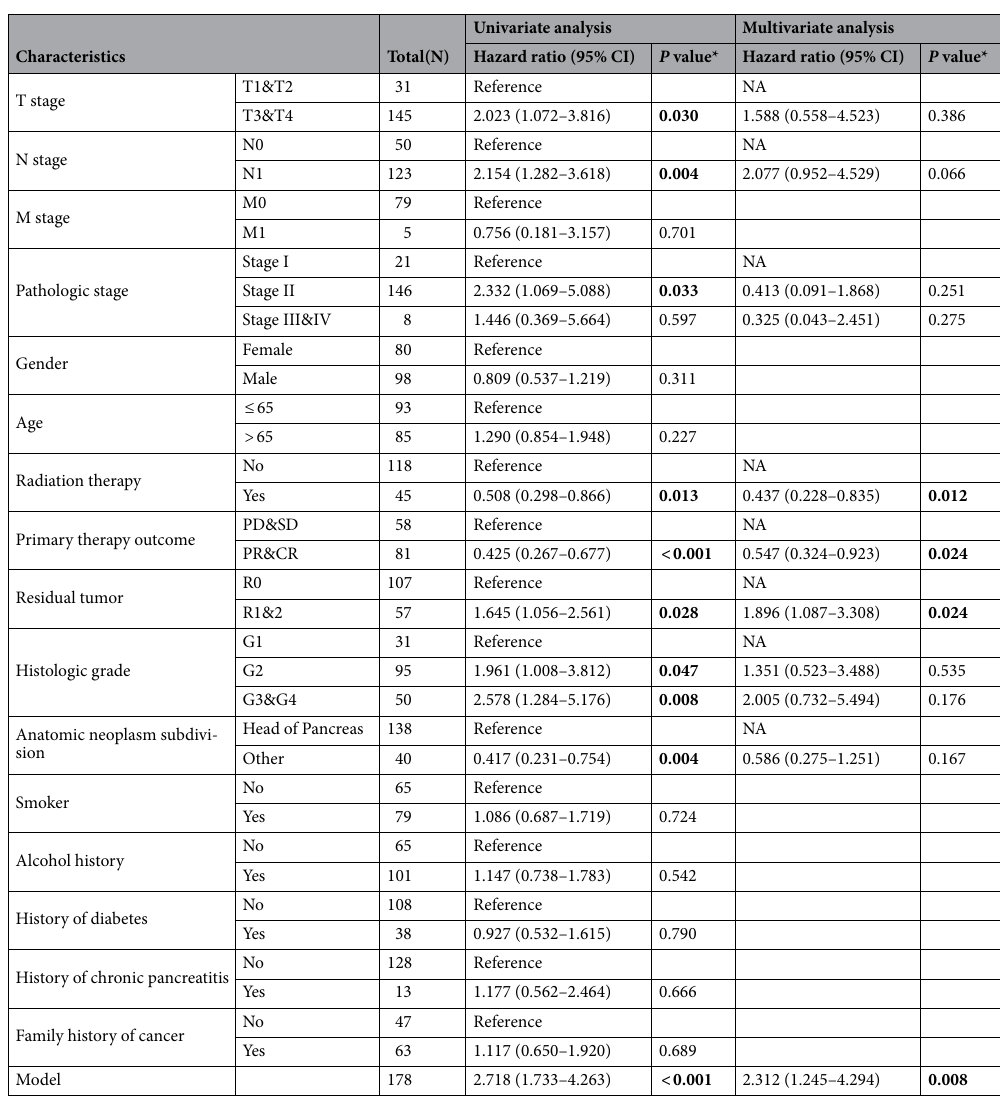
Table 2. The univariate and multivariate analysis for the OS (TCGA-PAAD). OS overall survival, CI confidence interval, NA reference group or could not be evaluated. *Compared with each group (Log-Rank test or Omnibus test for univariate, Cox regression analysis with adjusted hazard for multivariate). p < 0.05 means statistically significant (highlighted in bold).